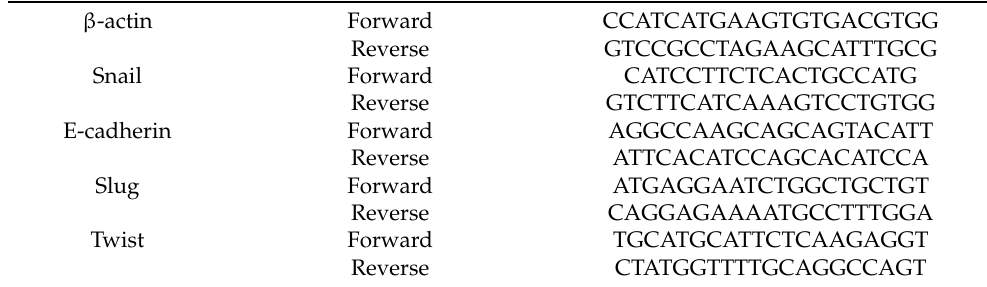
Table 2. Sequences of primers used in the